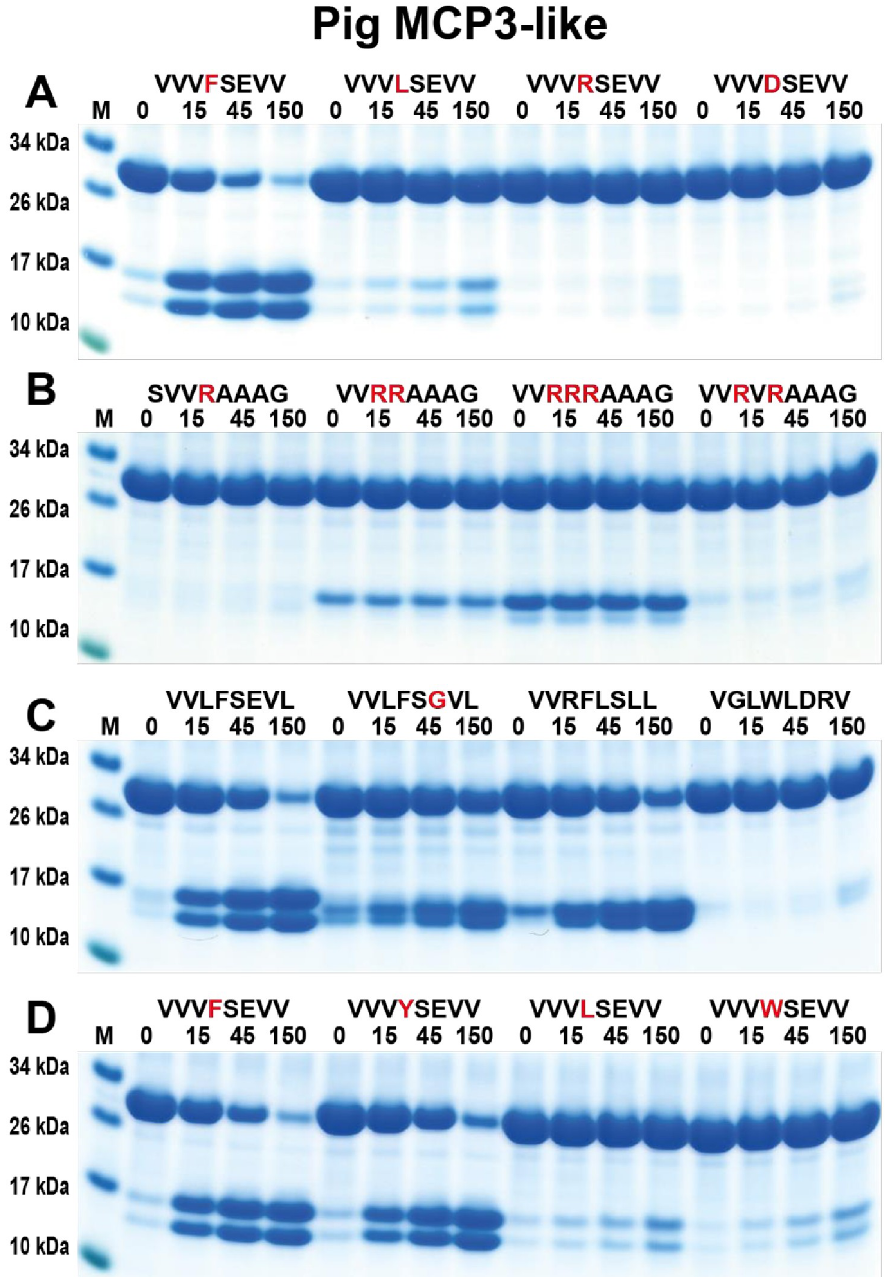
Fig 10. Verification of the cleavage specificity of pig MCP3-like using recombinant protein substrates. Panels A to D shows the cleavage of several substrates by the pig MCP3-like. The sequence of the different substrates are indicated above the pictures of the gels. The time of cleavage in minutes is also indicated above the corresponding lanes of the different gels. The uncleaved substrates have a molecular weight of ~25 kDa and the cleaved substrates appear as two closely located bands with a size of 12–13 kDa. Residues of particular interest and that may differ between different substrates are marked in red for an easy identification.